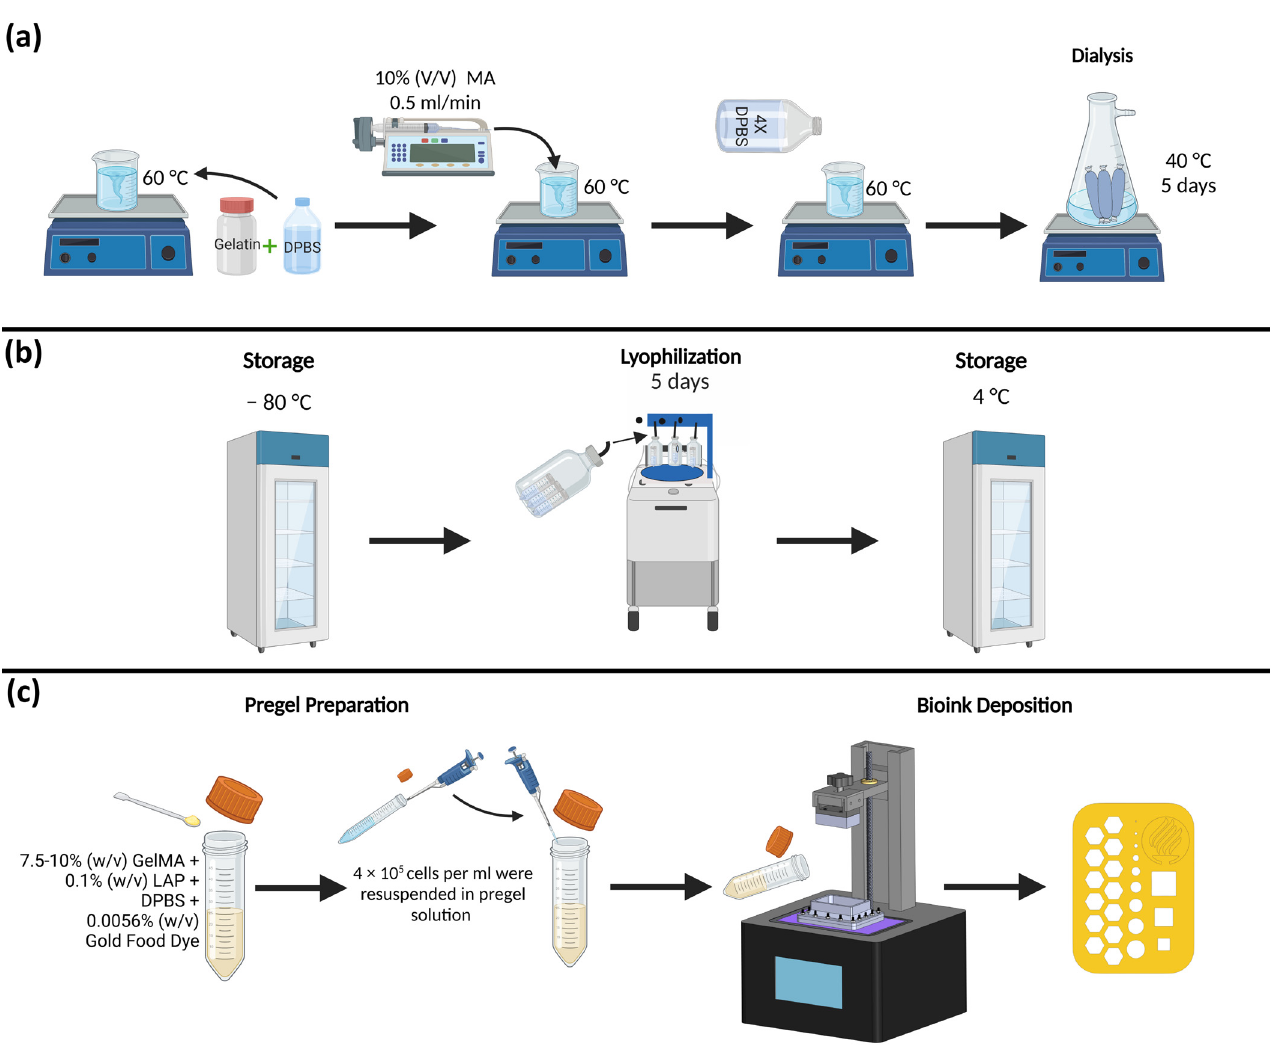
Figure 3. GelMA High synthesis deposition and testing steps: ( a ) compounds and processes used in GelMA synthesis; ( b ) lyophilization and storage phase; and ( c ) pregel preparation, cell seeding, bioink deposition, and example of the printed structure .